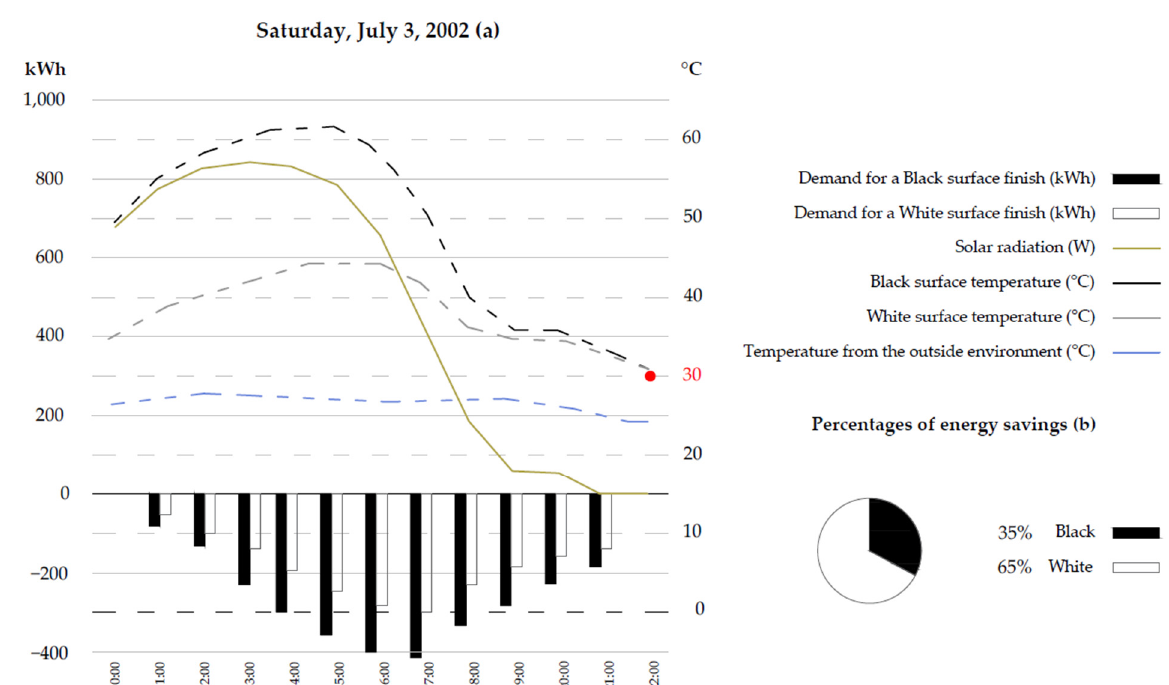
Figure 19. ( a ) Surface temperature and energy performance for 27 July 2002, in Madrid. ( b ) White vs. black surface finish energy savings.